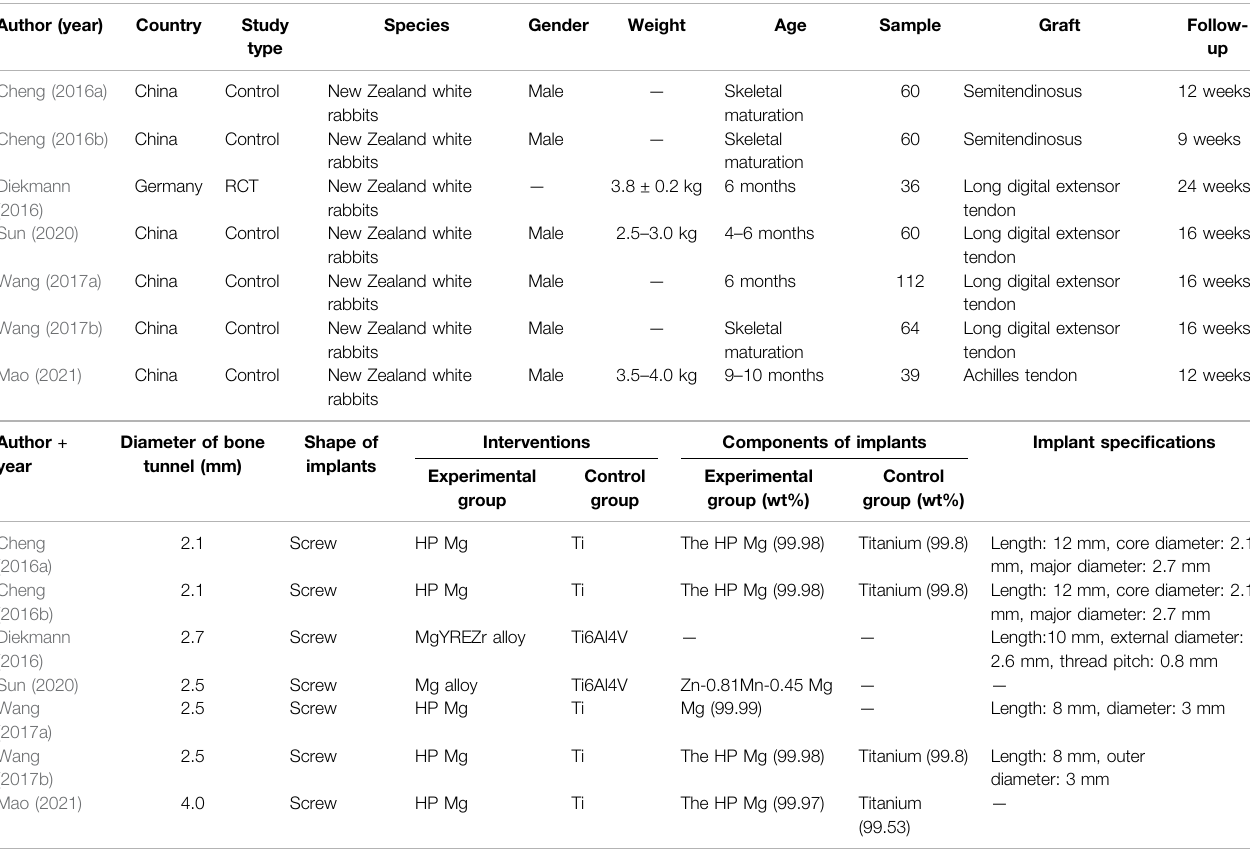
TABLE 1 | Basic information for inclusion in the study.